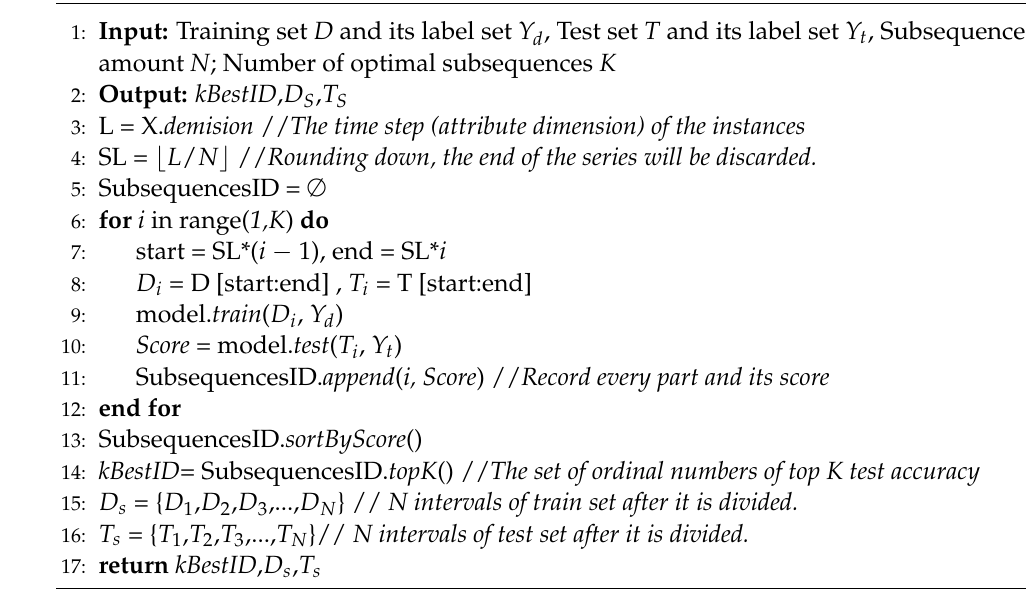
Algorithm 1 GetTopKBestSubsequences ( D , T , Y d , Y t , N , K ).